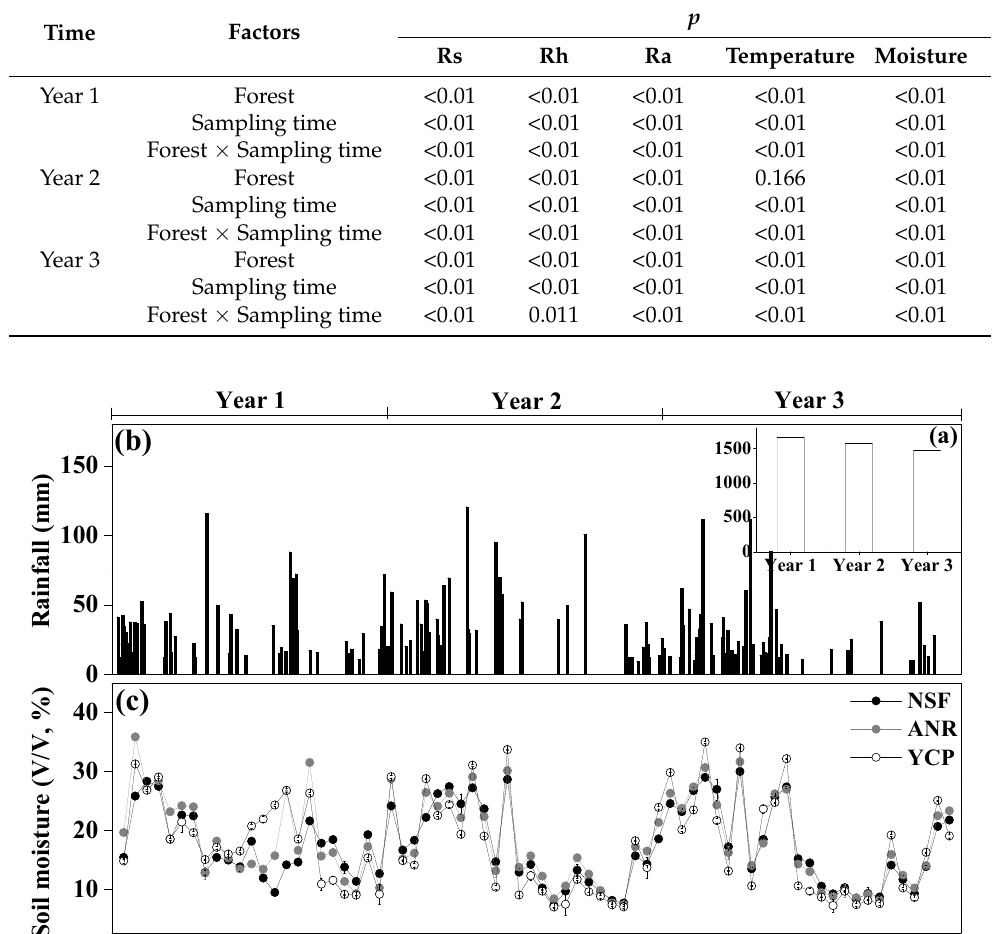
Table 1. Results of the two-way ANOVA showing the effects of forest type, sampling time and their interaction on total soil respiration (Rs), soil heterotrophic respiration (Rh), soil autotrophic respiration (Ra), soil temperature, and soil moisture.